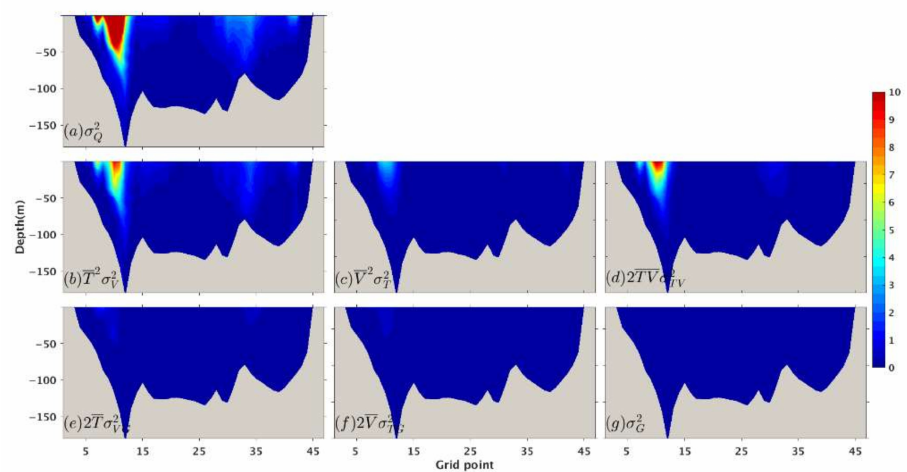
Figure 11. ( a ) denotes the total variance in heat transport across the TUS. ( b – g ) represent the six terms decomposed using Equation